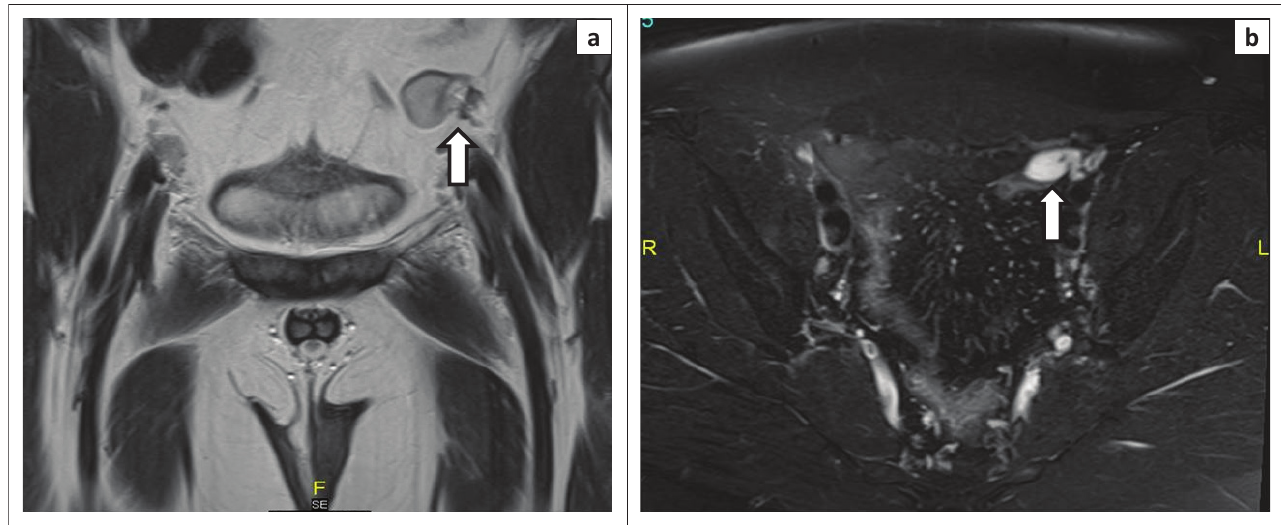
FIGURE 6: Use of contrast-enhanced imaging in a 7-month-old male with an undescended left testis: (a) Coronal T2W image shows a true undescended testis in the left iliac fossa (bold white arrow). (b) Axial post-contrast subtraction image confirms a homogenously enhancing undescended left testis (bold